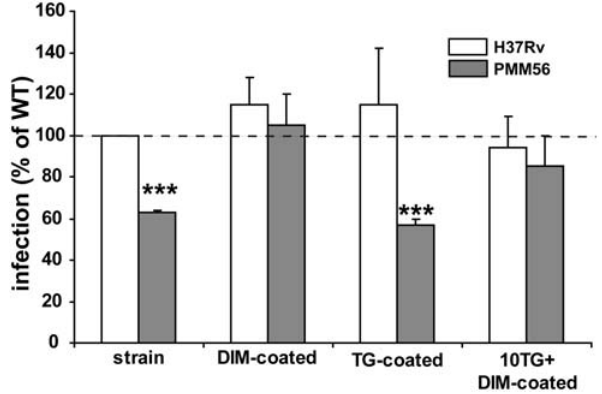
Figure 2. DIM contribute directly to macrophage infection by Mtb. MDMs were incubated for 60 minutes with strains at an MOI of 10: solvent-treated H37Rv WT or the PMM56 mutant uncoated or coated with DIM or triglycerides (TG) or DIM with excess TG. Data are expressed as a percentage infection with respect to the WT (H37Rv; 100%). The values are means 6 SEM of three separate experiments. We evaluated the significance of difference between the WT strain and the mutant or TG-coated mutant: *** p , 0.01.